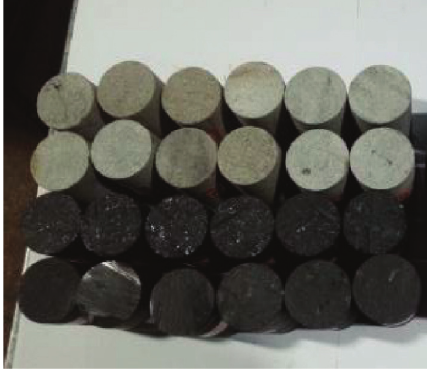
Figure 1: The samples of coal and sandstone.